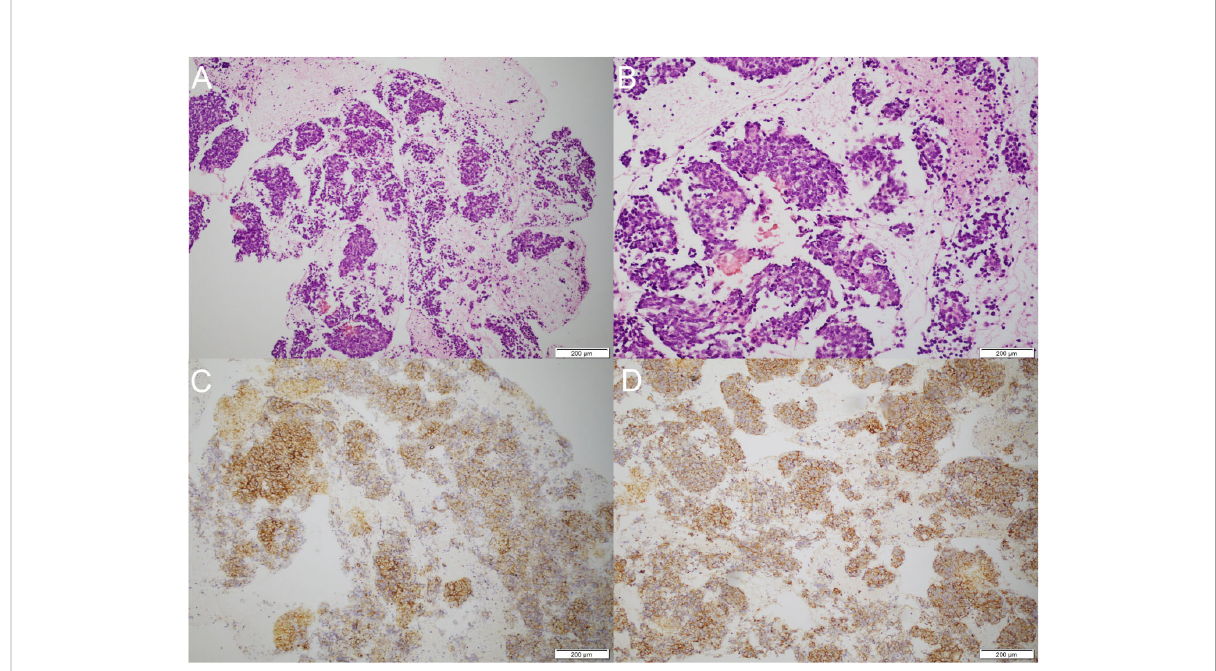
FIGURE 4 Pathological examination and immunohistochemistry. (A) Biopsy of paraesophageal lesion (hematoxylin – eosin staining, magni fi cation ×40). (B) Biopsy of paraesophageal lesion (hematoxylin – eosin staining, magni fi cation ×100). (C) The immunohistochemistry demonstrated positive results for synaptophysin. (D) The immunohistochemistry demonstrated positive results for